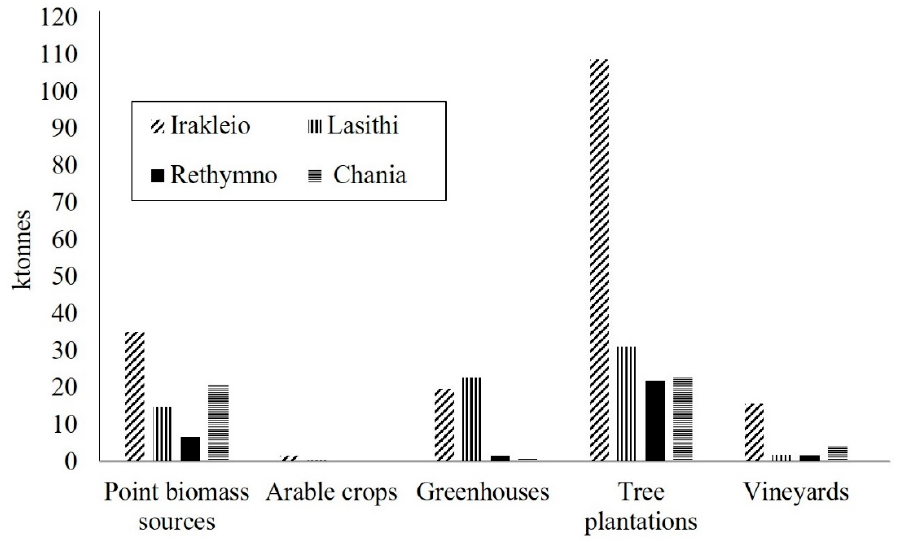
Figure 7. Biomass potential by source and Regional Unit of Crete (in ktonnes) [16,21,22].